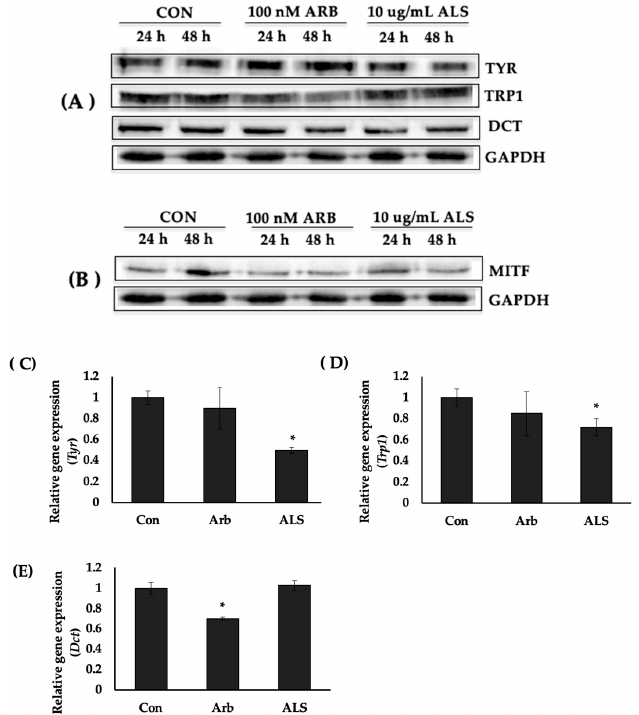
Figure 3. Saponins-rich fraction of argan leaves extract (ALS) modulates melanogenic enzymes expression in B16 cells. B16 cells were seeded at a density of 5 × 10 5 cells per 100 mm Petri dish. After overnight incubation, cells were treated with 10 µg /mL of saponins-rich argan leaf sample (ALS) or 100 µM arbutin (Arb) then incubated further at 37°C for 24 h or 48 h prior to protein extraction. Protein expression was determined by Western blotting. ( A ) Protein expression of melanogenesis enzymes tyrosinase (TYR), tyrosinase-related protein 1 (TRP1), and dopachrome tautomerase (DCT). ( B ) Protein expression of microphthalmia-associated transcription factor (MITF); gene expression of melanogenesis enzymes tyrosinase ( Tyr ) ( C ), tyrosinase-related protein 1 ( Trp1 ) ( D ), and dopachrome tautomerase ( Dct ) ( E ) determined using TaqMan real-time PCR. ). * indicates significance at p < 0.05.